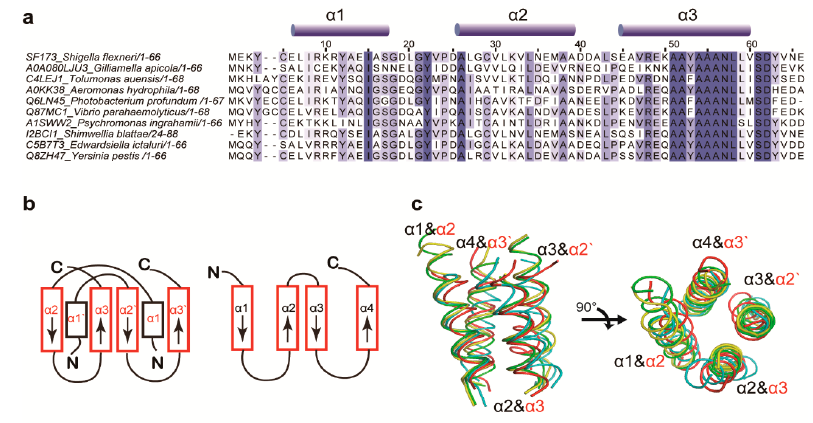
Figure 2. Structural similarity between TA0600-like domain proteins. ( a ) Multiple sequence alignment of homologous proteins in the UPF0253 family. Residue numbers and helix positions are presented for the SF173 sequence. Conserved residues are highlighted in blue, and the color intensity is proportional to the conservation score. ( b ) Comparison of the topology diagrams of the SF173 (left panel) and UPF0147-family protein (right panel) structures. ( c ) Structural superposition of SF173 (red) and UPF0147-family proteins (PDB ID 2QZG, yellow; 2FU2, cyan; 2QSB, green) in the four-helix bundle scaffold. The labels of the secondary structure of UPF0147-family and SF173 proteins are colored black and red, respectively.